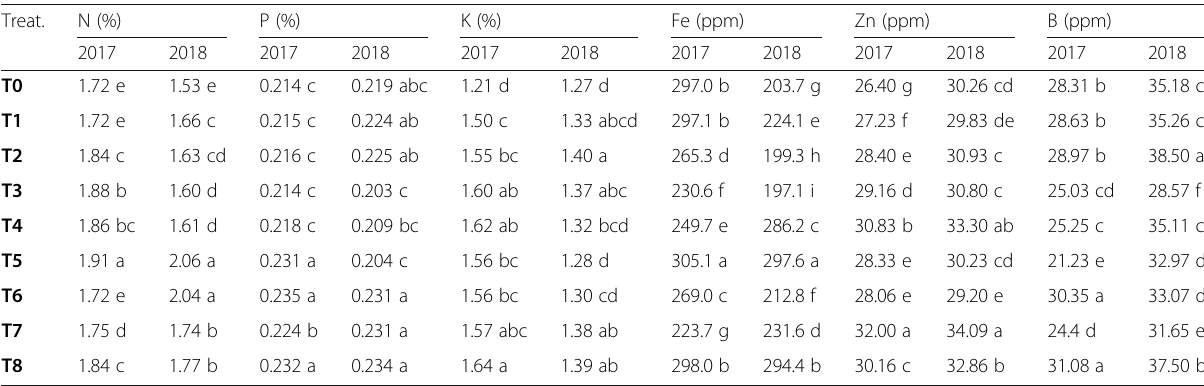
Table 4 Effect of foliar application of B 2 O 3 and ZnO nanoparticles on leaf minerals content of Picual cultivar in 2017 and 2018 seasons